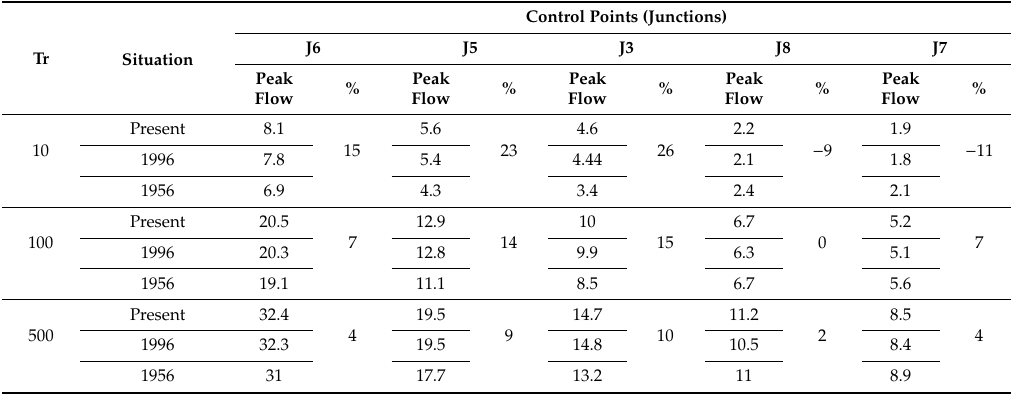
Table 6. Hydrological modelling results. The di ff erent return periods considered and the consequent peak flow discharges (m 3 / s) at the control points J3, J5, J6, J7 and J8 are shown. % indicates the percentage of change between the 1956 and present situations.